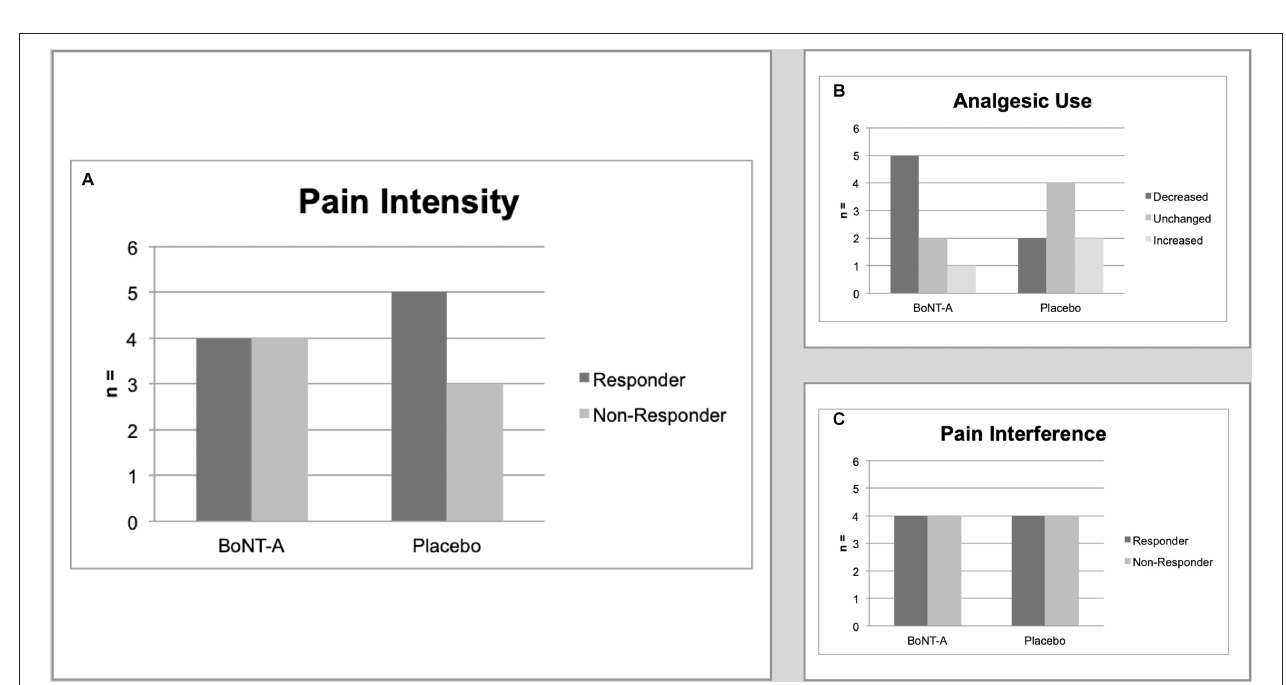
FIGURE 2 | Main study outcomes. (A) Primary outcome. The number of treatment responders (defined as a reduction of ≥ 2 scale steps on the NRS) at 6 weeks after treatment, by treatment group. Test of proportions, p = 1.000. (B) Secondary outcome. The number of treatment responders (defined as change in categories of analgesics use) at 6 weeks after treatment, by treatment group. Test of proportions p = 0.429. (C) Secondary outcome. The number of treatment responders (defined as a reduction of mean interference score of ≥ 1 on the BPI) at 6 weeks after treatment, by treatment group. Test of proportions p = 1.000. BPI, Brief Pain Inventory; NRS, Numerical Rating